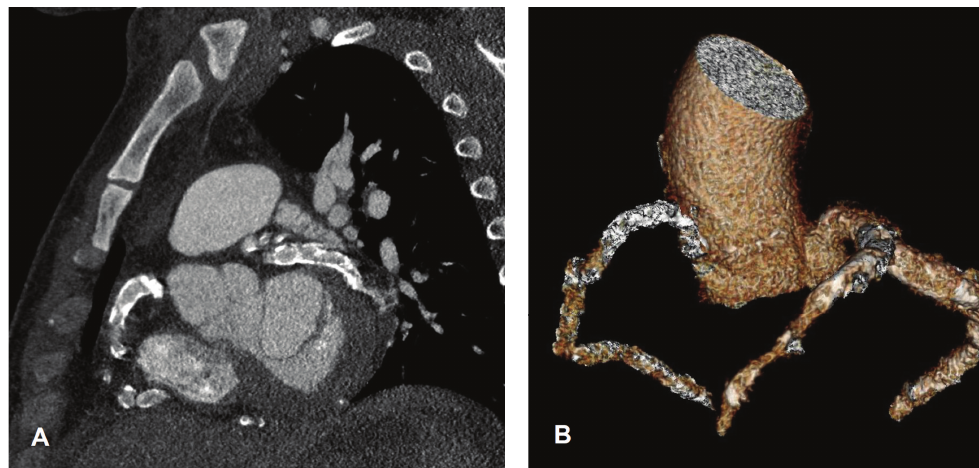
Figure 2: Dual source computed tomography showing (A) di ff use calcification in RCA and LCx and (B) 3-dimensional volume rendering image demonstrating coronary arteries